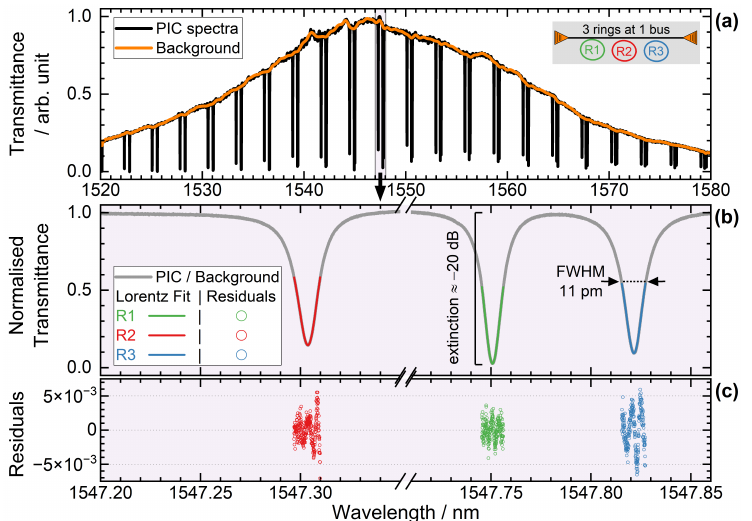
Figure 2. Data Processing of the photonic integrated circuit spectra with three ring resonators (inset). ( a ) Raw data of PIC transmittance and estimated background, arising from grating coupler and optical setup; ( b ) The PIC transmittance, normalised by the background, shows the characteristics of the resonators. A Lorentz fit of the peak region is used to determine the exact position of λ m and other parameters. ( c ) Residuals of the peak